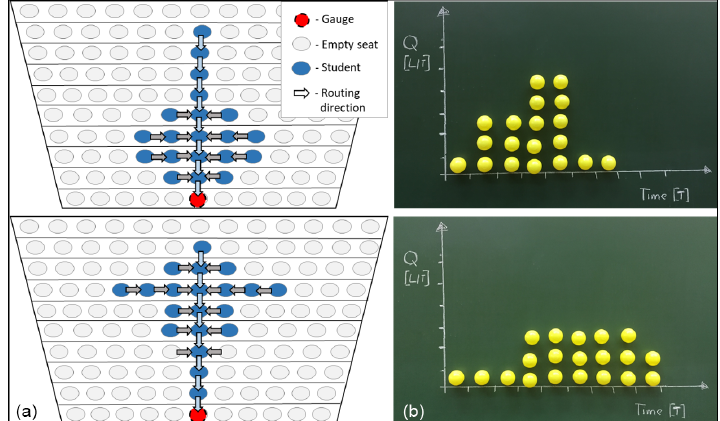
Figure 6. The effect of different catchment forms (same area/number of students) (a) , on the resulting hydrographs (b)